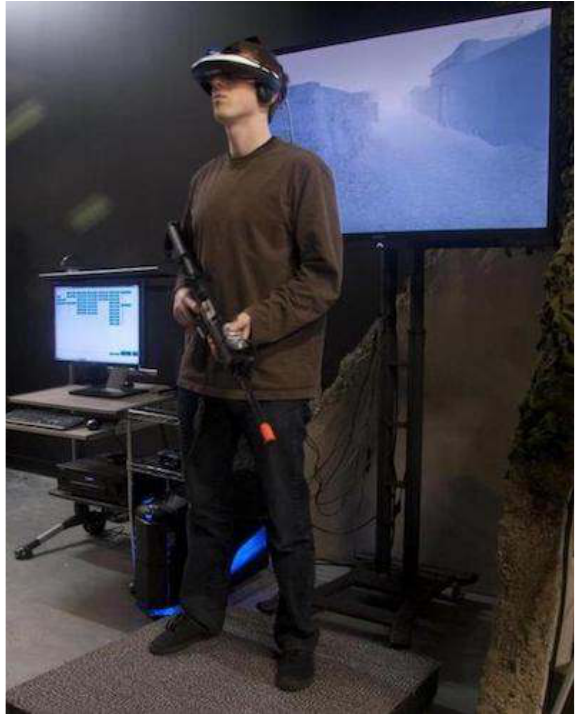
Figure 1: Example set-up of Bravemind session